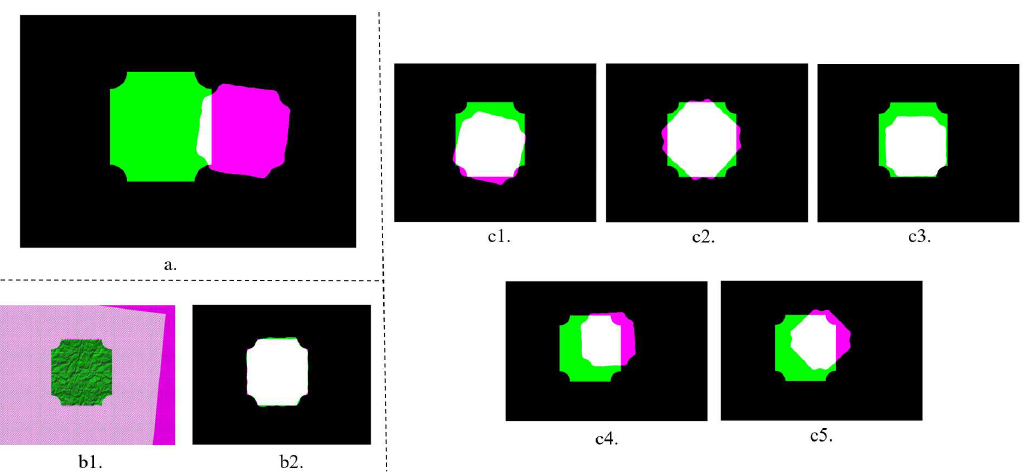
Figure 5. A comparison of each algorithm, ( a ) Initial image pair; ( b ) Registered origin pair by SSR ( b1 ) and registered segmented pair by SSR ( b2 ); ( c ) Results of other algorithms, ( c1 ) Mean Squares, ( c2 ) Mattes MI, ( c3 ) Phase-correlation, ( c4 ) Powell and ( c5 ) PSO.